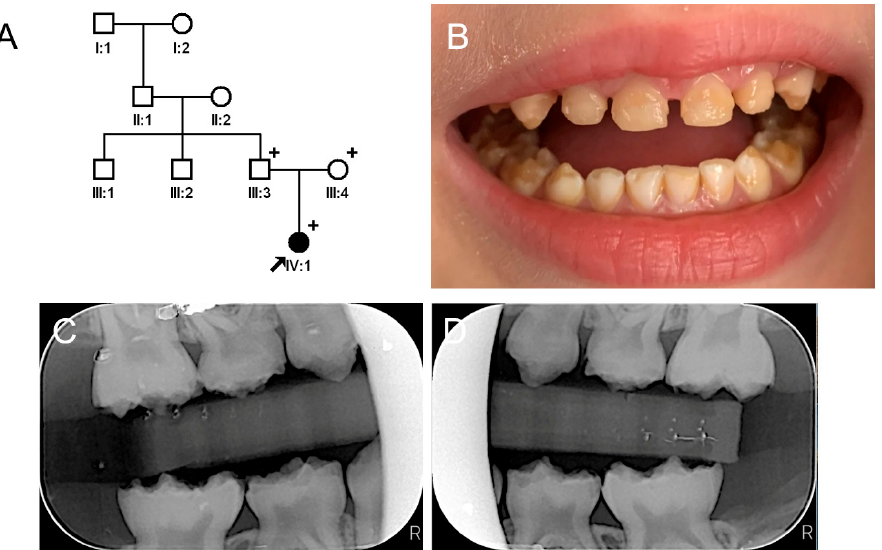
Figure 5. Pedigree, clinical photo, and bitewing radiographs of family 3. ( A ) Pedigree of family 3. The black symbol indicates the affected individual, and the proband is indicated by a black arrow. A plus sign above the symbol indicates participating individuals. ( B ) Clinical photo of the proband at age 4 years. She has a dull yellowish-brown discoloration of her dentition, and the affected enamel shows attrition and fractures. ( C , D ) Bitewing radiographs of the proband at age 4 years show enamel fractures with reduced radiopacity.